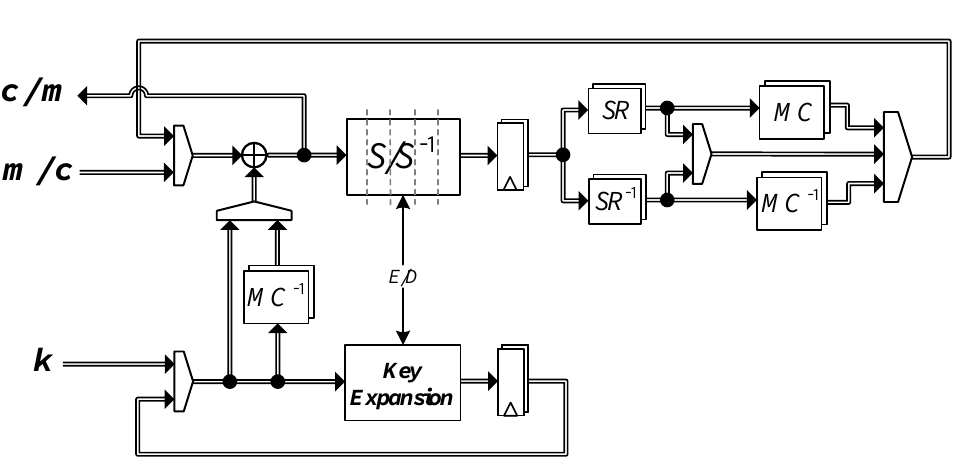
Figure 3: 2-share masked round-based AES-128 supporting encryption and